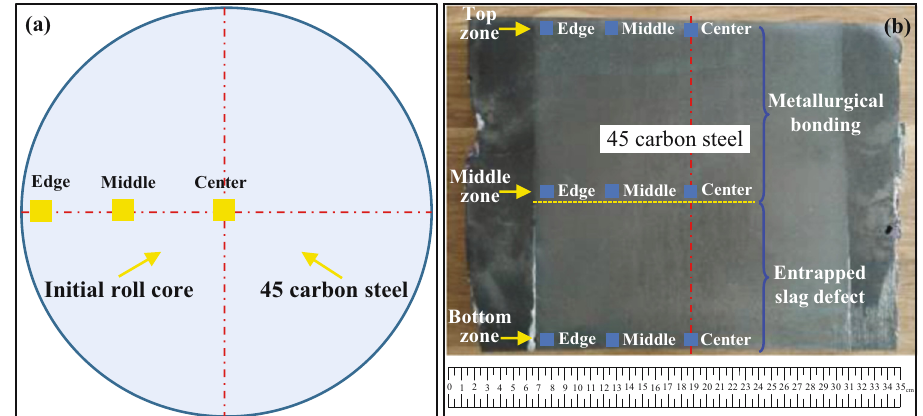
Figure 4: Diagram of specimens taken from the roll core ( a ) before and ( b ) after the ESRC